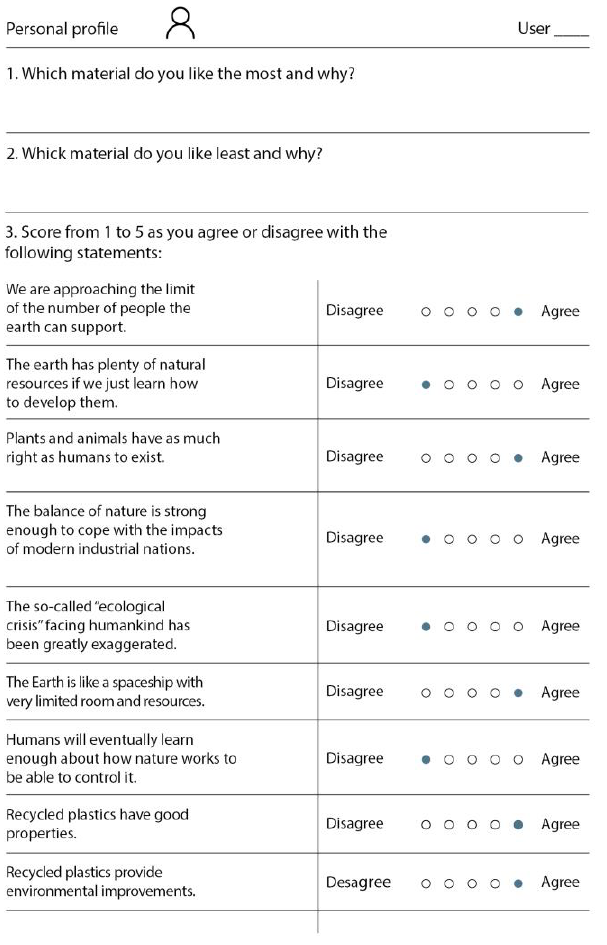
Figure 6. Environmental attitude questionnaire. A blue circle is used to show the answer that is associated with a better environmental